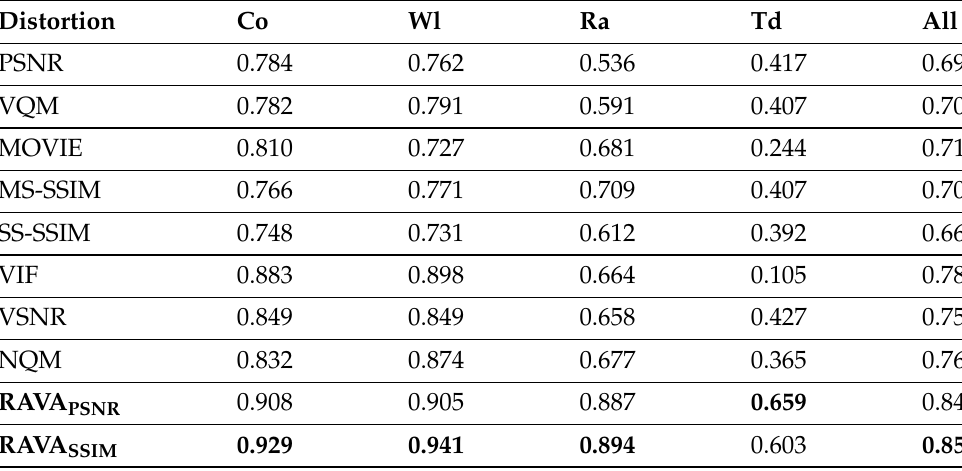
Table 3. Comparison of PCC (Pearson correlation